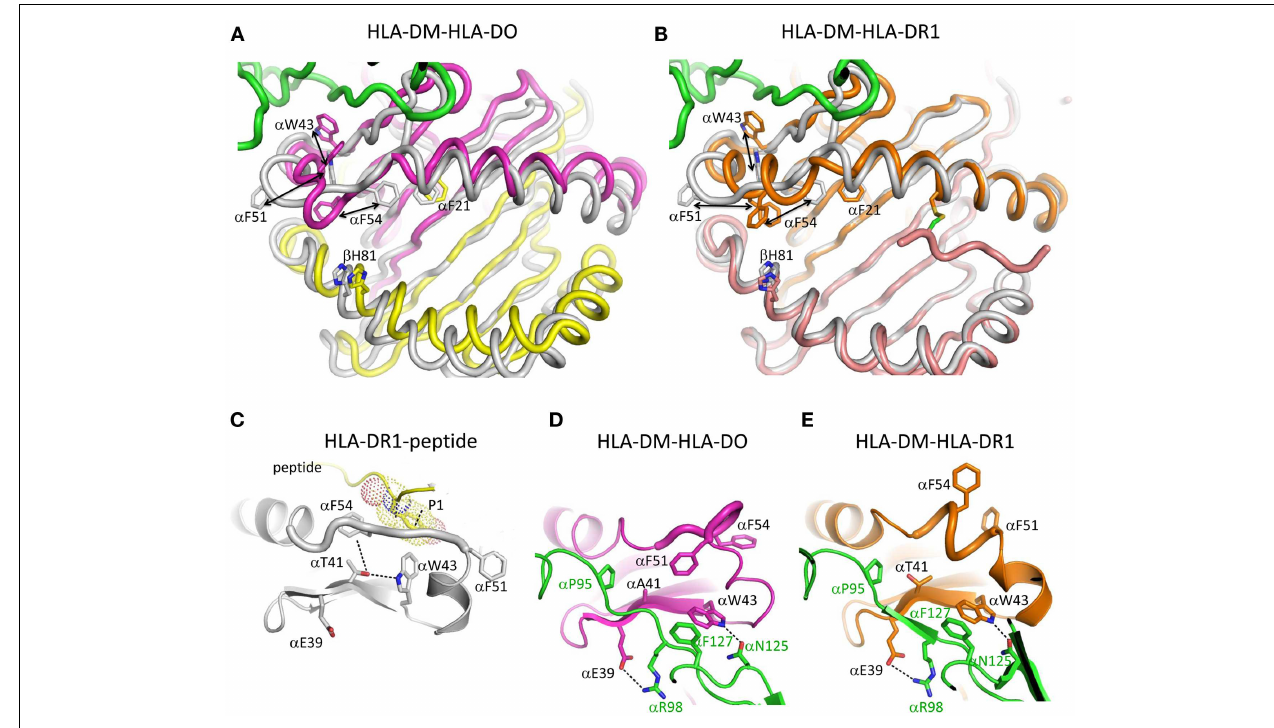
residues in the vicinity of the P1 site are highlighted in (A) and (B) . Conformations of alpha 310 helix and extended strand region are shown for (C) HLA-DR1 bound with an influenza peptide (HA306-318), (D) HLA-DO bound with HLA-DM, and (E) HLA-DR1 bound with HLA-DM. Each subunit is colored the same as above. In (C) HLA-DR1 α W43 points into P1 pocket while α F51 and α F54 both point out; in (D) HLA-DO α W43 flips out to interact with α N125 from HLA-DM, while α F54 moves to the P1 pocket; in (E) HLA-DR1 α W43 also flips out to interact with α N125 from HLA-DM, while α F51 not α F54 moves to the P1 pocket. Other important residues are also indicated in each